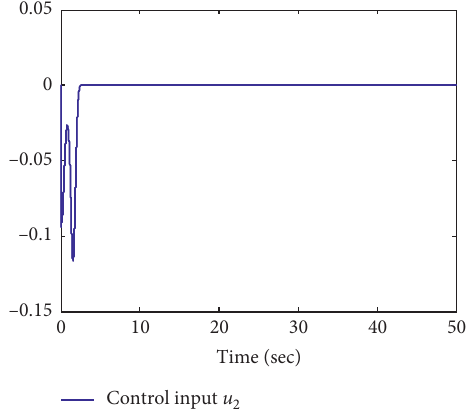
Figure 4: Control input u